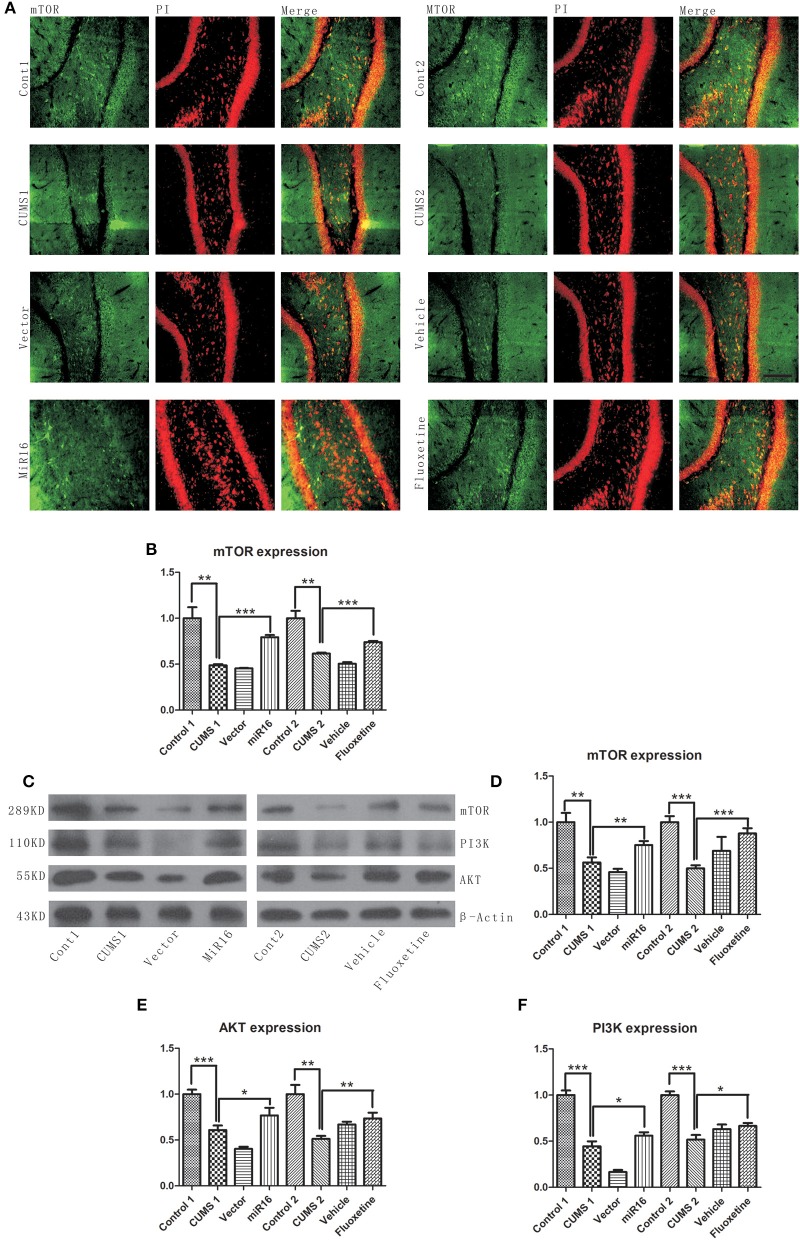
miR-16 treatment and Fluoxetine treatment was able to significantly increase PI3K/Akt/mTOR activity. (A) Images of mTOR Immunofluorescence staining show a decrease expression level in the CUMS groups compared with the Control groups. (B) Mean change in mTOR expression detected by immunofluorescence. (C) Compared with the Control groups, the protein expressions of mTOR, PI3K, and AKT levels decreased in the CUMS groups. Histograms from mTOR protein level (D), AKT protein level (E) and PI3K protein level (F) show significant restoration toward control levels in both miR-16 and Fluoxetine groups. Values are the means ± SEMs. *P < 0.05; **P < 0.001; ***P < 0.0001.